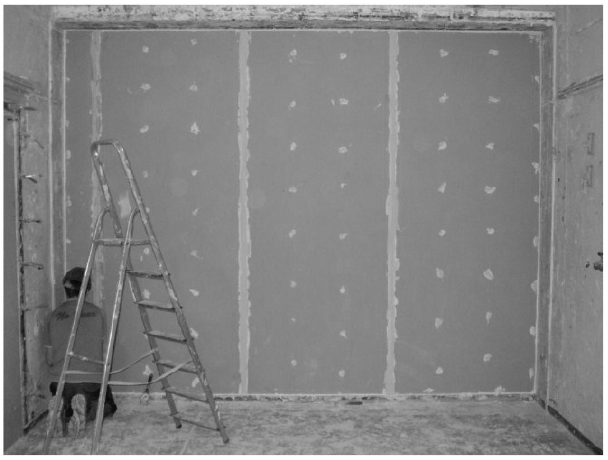
Figure 5. Mastic sealing on the metal-framed wall perimeter for the experimental test.